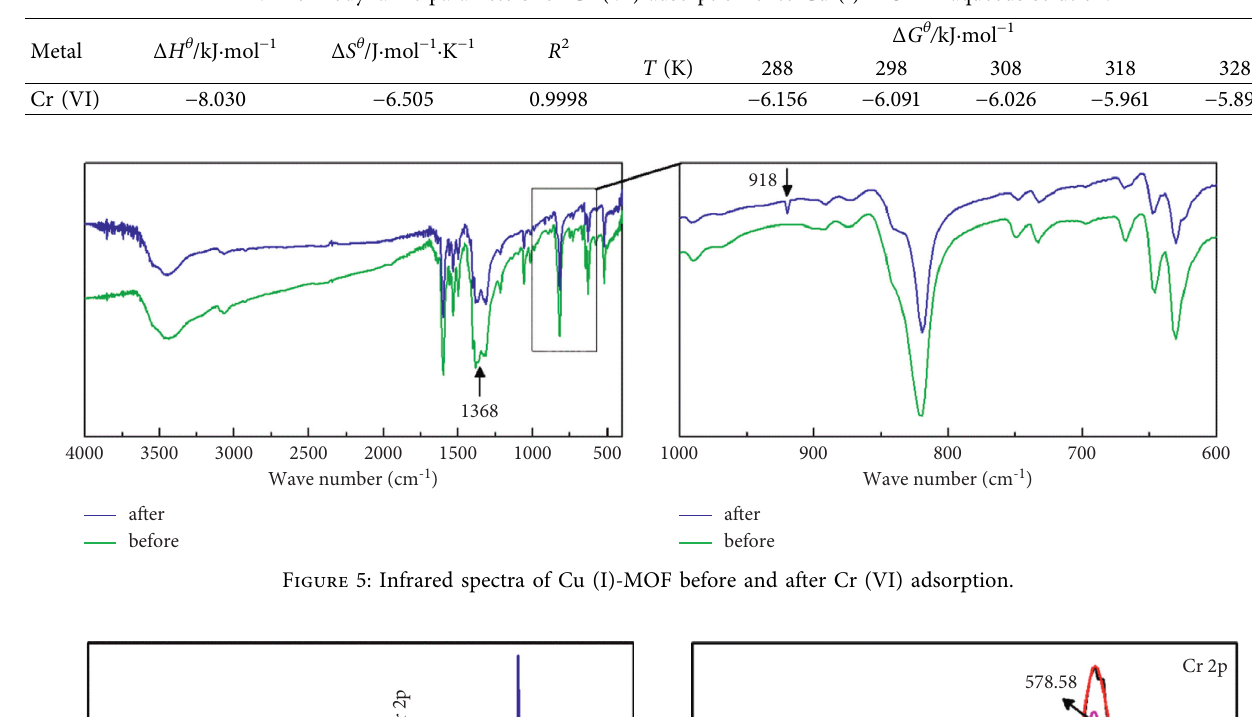
Table 4: Thermodynamic parameters for Cr (VI) adsorption onto Cu (I)-MOF in aqueous solution.